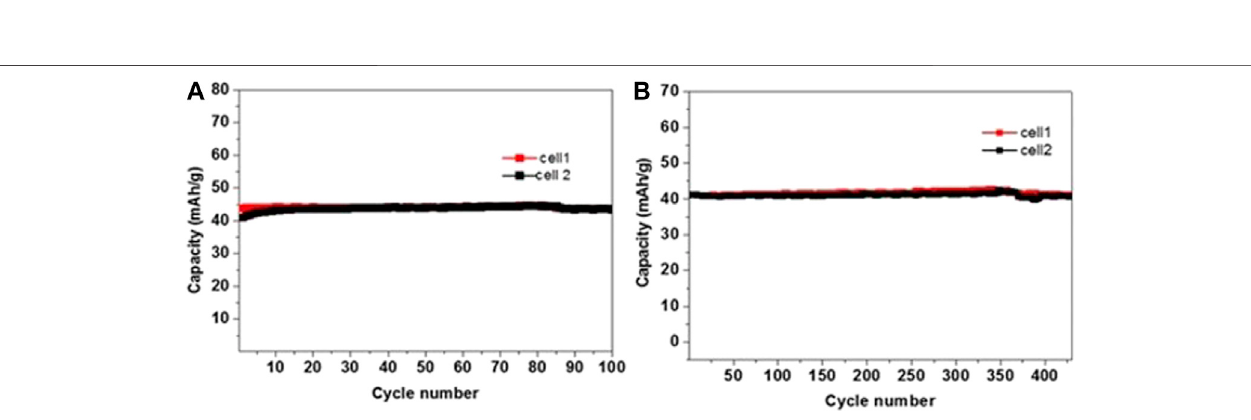
FIGURE 10 | (A) Representative plot of capacity vs. cycle number of balanced NMO-PI/saturated aqueous NaClO 4 electrolyte solution full cells operating galvanostatically between0and1.7 VatC/2, 1C,2C,5C,and 10C(sixcycles ateachrate). (B) Correspondingsixthcyclecharge – discharge voltagepro fi lesofthesefull cells at different rates. 1C meaning a current density adjusted for full charge and discharge process within 1